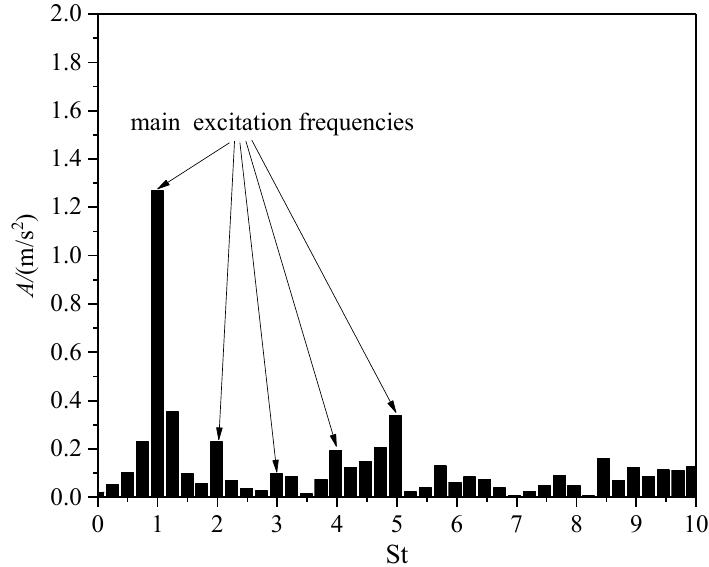
Figure 16. Typical vibration spectrum of No. 1 measuring point at 1.0 Q d .